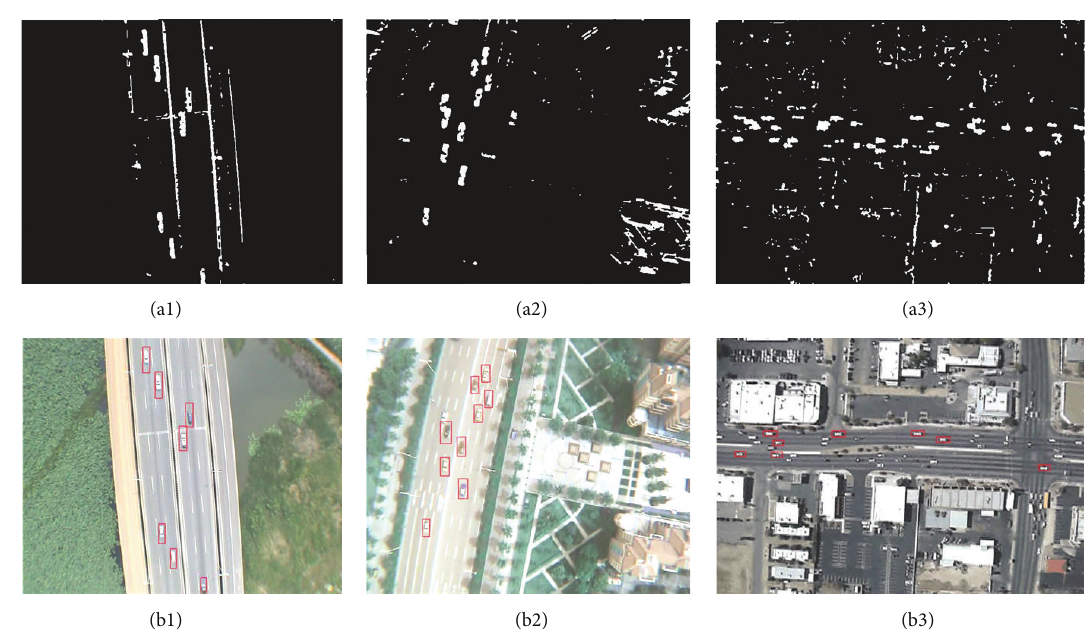
Figure 14: Vehicle detection results of the proposed method.